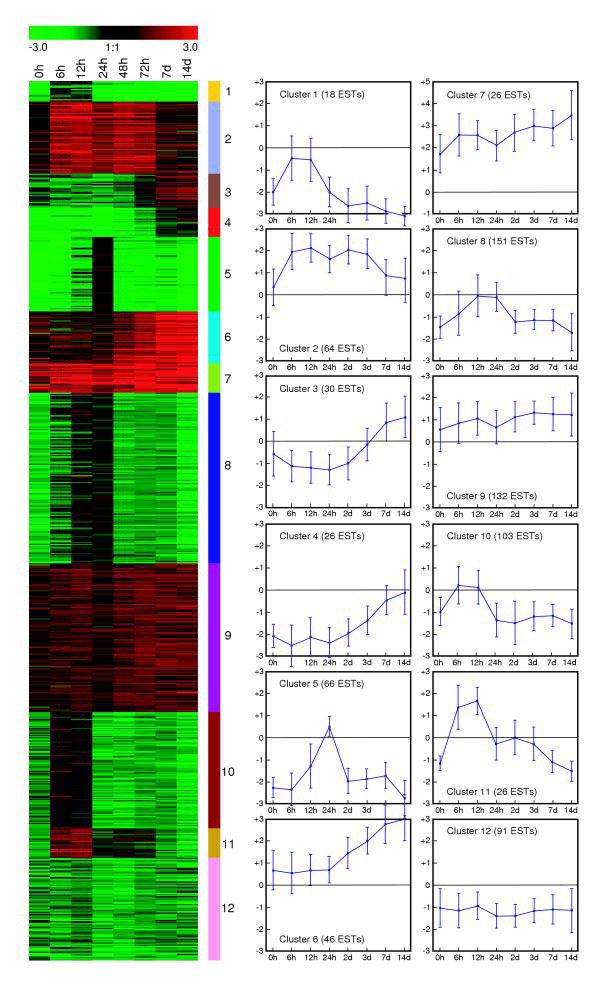
Clustering of ESTs found to be differentially expressed during fat cell differentiation. Shown is k-means clustering of 780 ESTs found to be more than twofold upregulated or downregulated at a minimum of four time points during fat cell differentiation. ESTs were grouped into 12 clusters with distinct expression profiles. Relative expression levels (log2 ratios) for EST gene at different time points are shown and color coded according to the legend at the top (left) and expression profile (mean ± standard deviation) for each cluster (right). EST, expressed sequence tag.